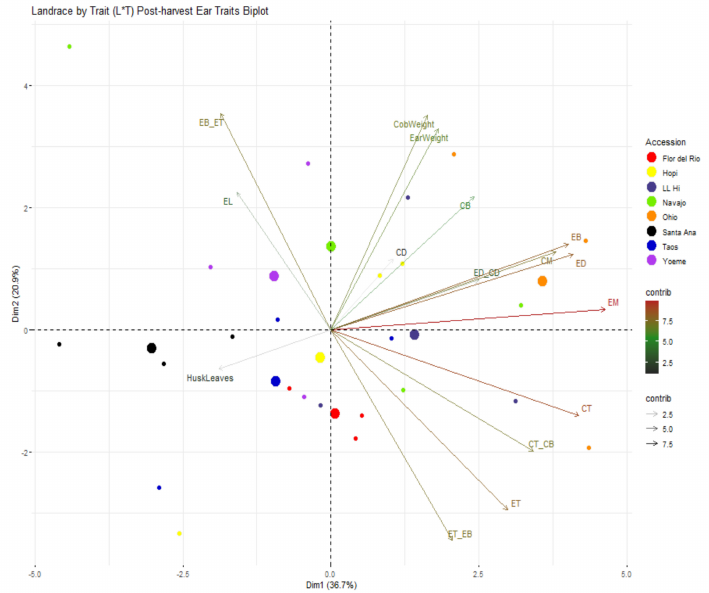
Figure 8. Landrace by trait (L*T) biplot for post-harvest ear traits. Some traits shown in this figure has been abbreviated and full forms for the abbreviated traits are presented in Table 5. Landraces from Navajo Blue, LL High, Santa Ana Blue, Flor del Rio, Yoeme Blue, Ohio Blue, Hopi Blue, and Taos Blue are shown in “chartreuse2”, “slateblue4”, “black”, “red1”, “darkorchid2”, “darkorange”, “yellow” and “blue3”, respectively. Traits contributing to PC1 and PC2 are also assigned different colors with a gradient ranging from 2.5, 5, and 7.5 with “gray15”, ”forestgreen” and “firebrick” respectively. Larger consensus points for each accession discerns the midpoint of a given accession.